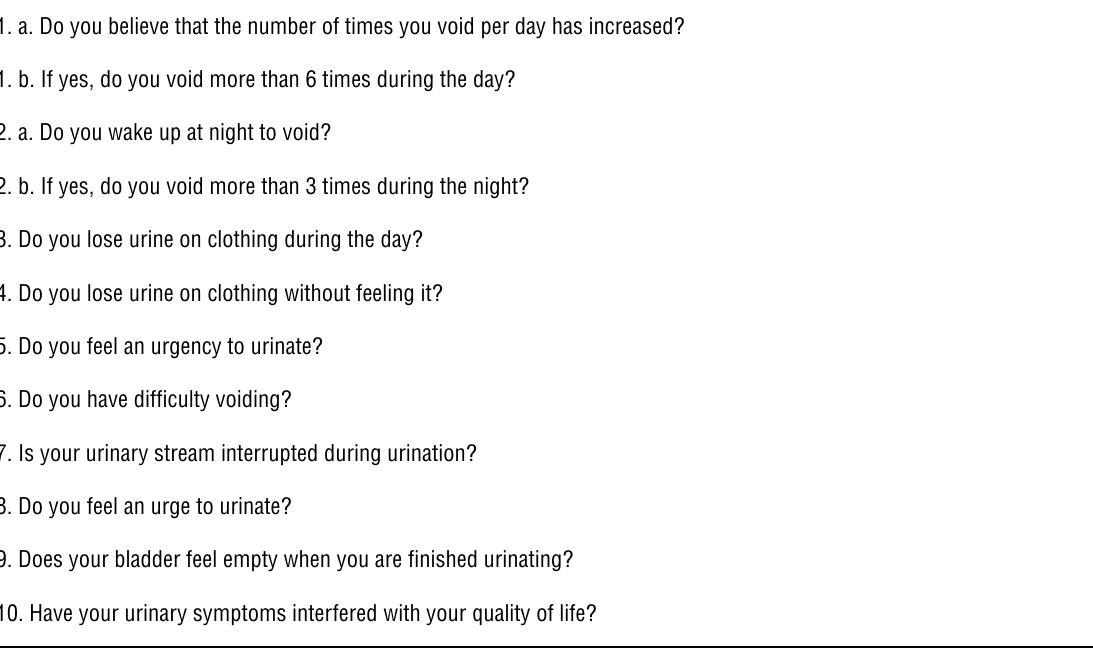
Table 1 - Questionnaire of urinary